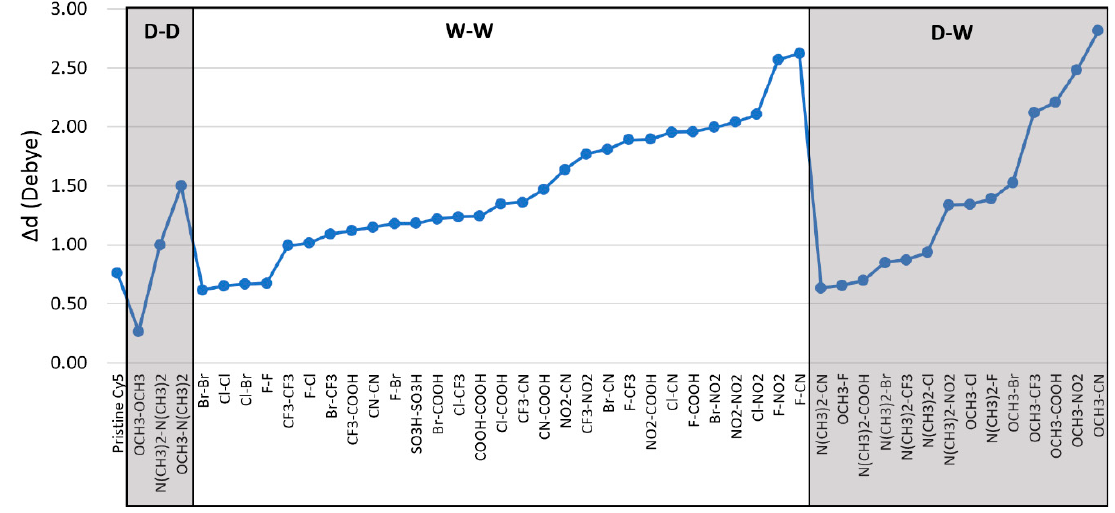
Figure 4. Static dipole difference magnitudes ( ∆ d ) of pristine and substituted Cy5 dyes calculated using Equation (2). The given substituent groups are placed on R 1 and R 1 ’ sites in Figure 1. Ground state optimizations and excited state single point calculations were performed using the M06-2X functional. The dyes are grouped according to substituent classification and ordered according to increasing ∆ d . The lines added to the data are to highlight trends and are not meant to infer a quantitative behavior.